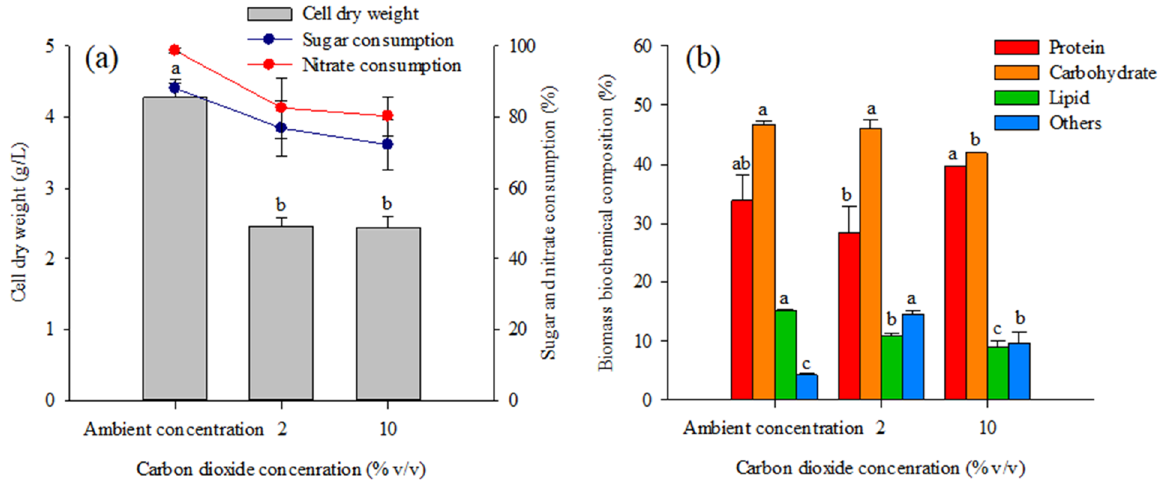
Figure 6. Effect of CO 2 concentration on ( a ) biomass production and sugar and nitrate consumption and ( b ) composition of Coelastrella sp. KKU-P1 biomass obtained from cultivation in molasses-based medium. Different lowercase letters on the top of the bars indicated that the data are significantly different ( p ≤ 0.05, ANOVA with Duncan’s multiple range test).